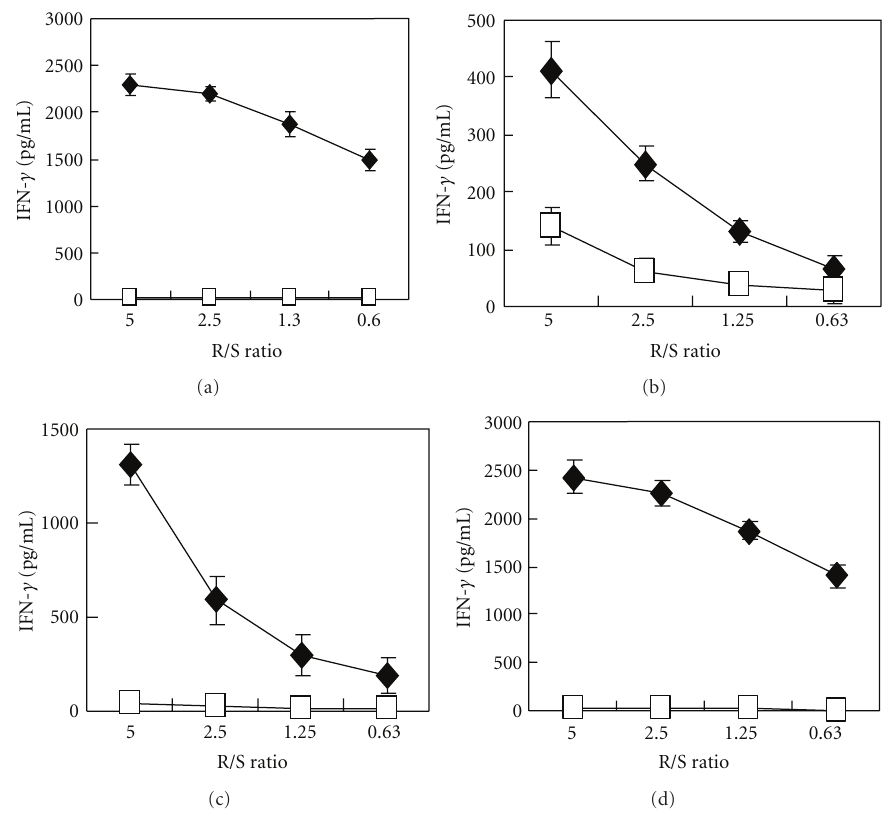
Figure 2: Peptide-specific IFN- γ production by CTL clones. IFN- γ production by CDH3-10-807 peptide-specific CTL clone (a), KIF20A-9- 305 peptide-specific CTL clone (b), KIF20A-10-304 peptide-specific CTL clone (c), and KIF20A-10-66 peptide-specific CTL clone (d), when stimulated with TISI cell pulsed with corresponding peptide (closed diamond) or HIV-A24 peptide (open square). CTL clones produced significant amount of IFN- γ responding to corresponding peptide. IFN- γ ELISA was performed triplicate. R/S ratio, responder cell (CTL clone)/stimulator cell (TISI cell)